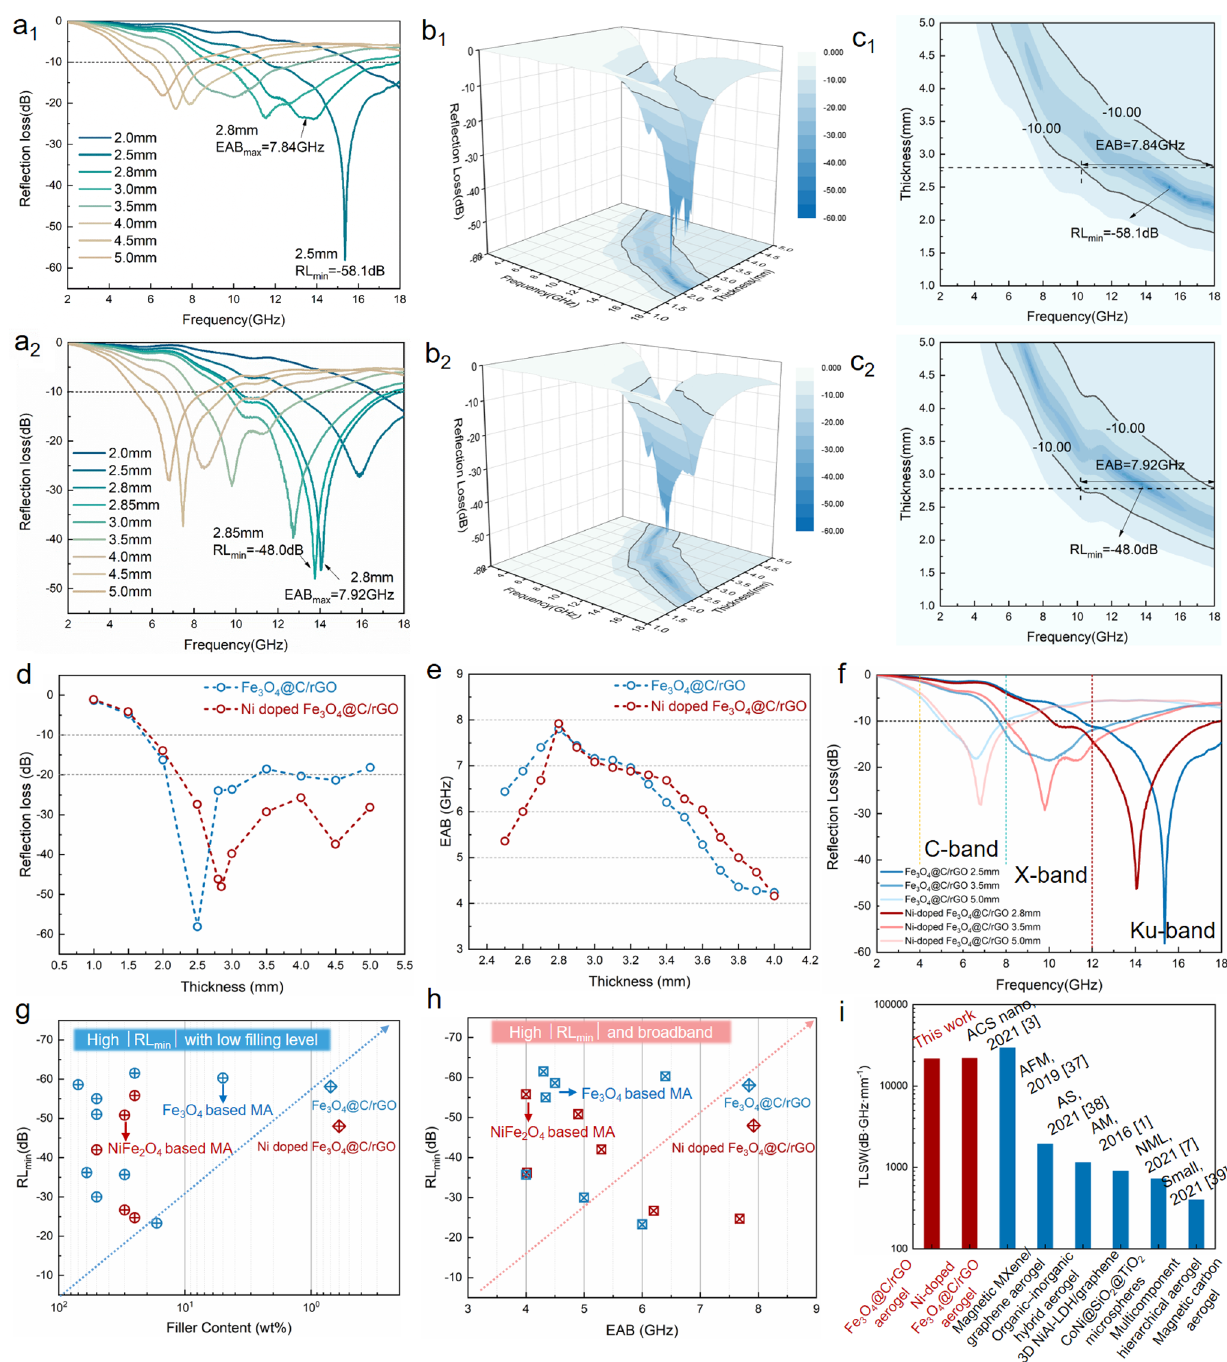
Fig. 6 a RL − f curves, b 2D, and c 3D representations of the RL values. d RL min and e EAB values at different thicknesses. f Selected RL –f curves at different wavebands. g , h Comparison of the EMA performance considering the RL min , filler content, and EAB with reported spinel structured MFe 2 O 4 (M = Fe and Ni) composites. i TLSW values of the reported representative EMA